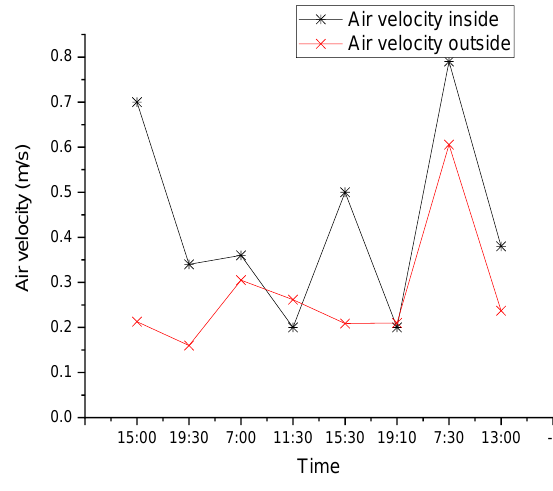
Figure 6. Relative air humidity.